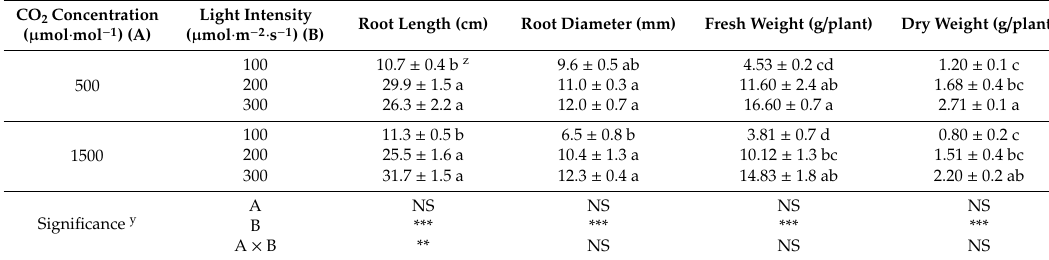
z Mean separation within columns using Tukey’s multiple range test at p ≤ 0.05. y NS, **, *** Nonsignificant or significant at p ≤ 0.01 or 0.001, respectively.